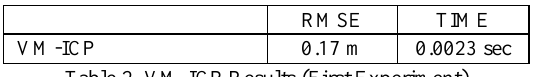
Table 2. VM-ICP Results (First